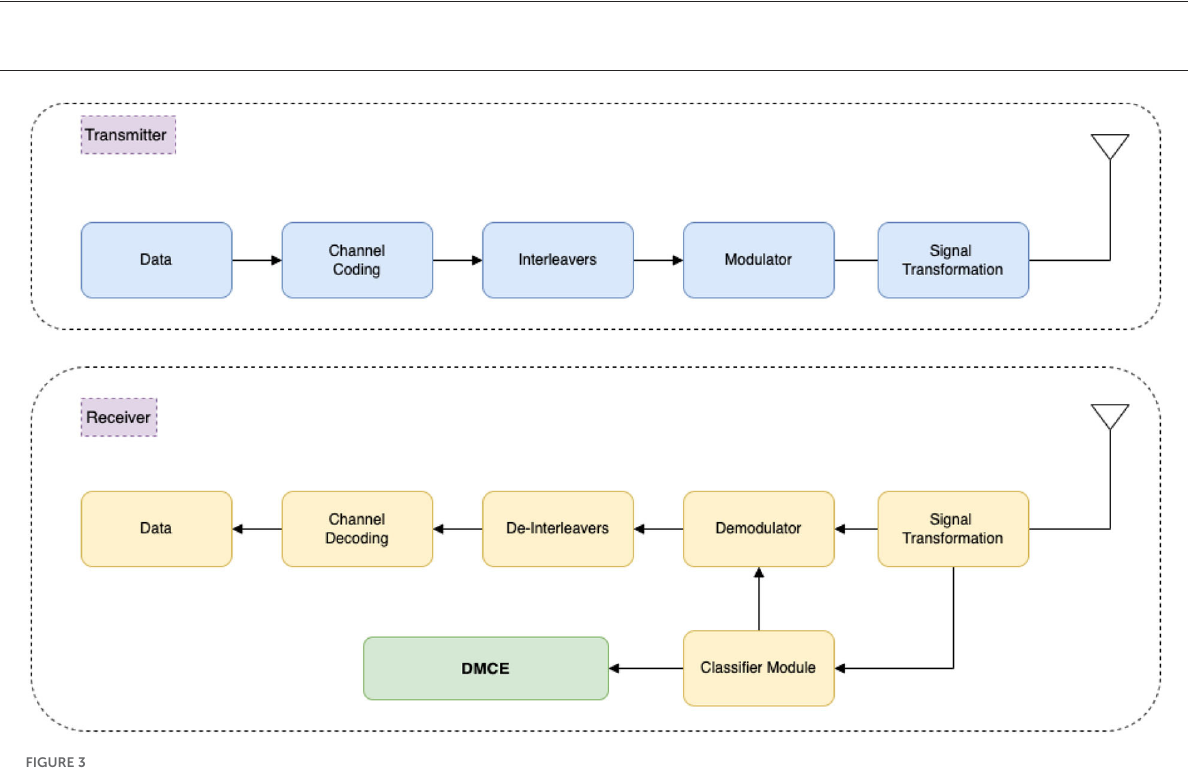
FIGURE3 A complete overview of end-to-end pipeline of a standard communication system and understanding of locating our DMCE block in the communication